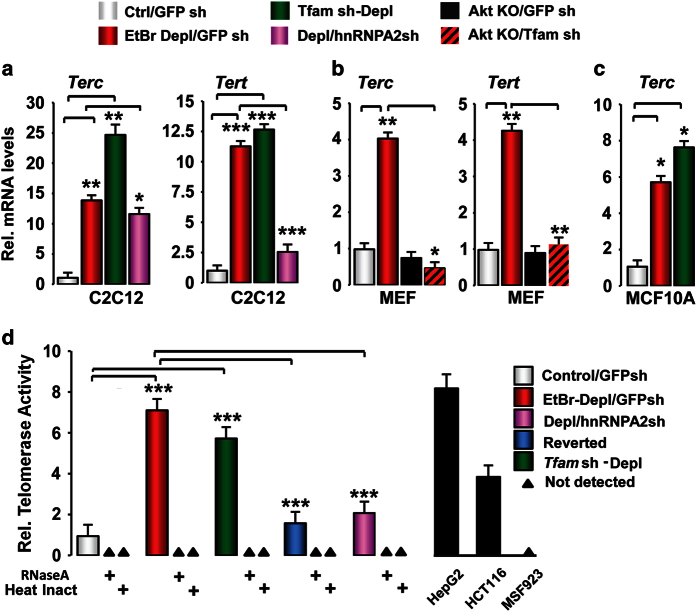
PmtDNA depletion induces telomerase activation by hnRNPA2. (a) Transcript levels
of Tert and Terc in control, PmtDNA-depl and PmtDNA-depl/hnRNPA2sh
C2C12 cells assessed by real time PCR. (b) Terc and Tert
transcript levels in wild-type (WT) and protein kinase B/AKT kinase (AKT) knockout (KO)
mouse embryonic fibroblast (MEF) parental and Tfam shRNA cells. (c)
Transcript levels of Terc in parental and PmtDNA-depl MCF10A cells assessed by
real time PCR. (d) Q-TRAP assay for telomerase activity was assessed in total
cell extracts (1 μg protein) from control, PmtDNA-depleted (EtBr-treated or
Tfam shRNA), PmtDNA-depl/hnRNPA2sh and reverted C2C12 cells. Cell extracts
were treated either with RNAse or heat inactivated for negative controls. The telomerase
expressing cancer cell lines HepG2 and HCT116 are used as positive controls and
Terc null msf 923 cell lysate was used as a negative control. Data are
represented as mean±s.d.